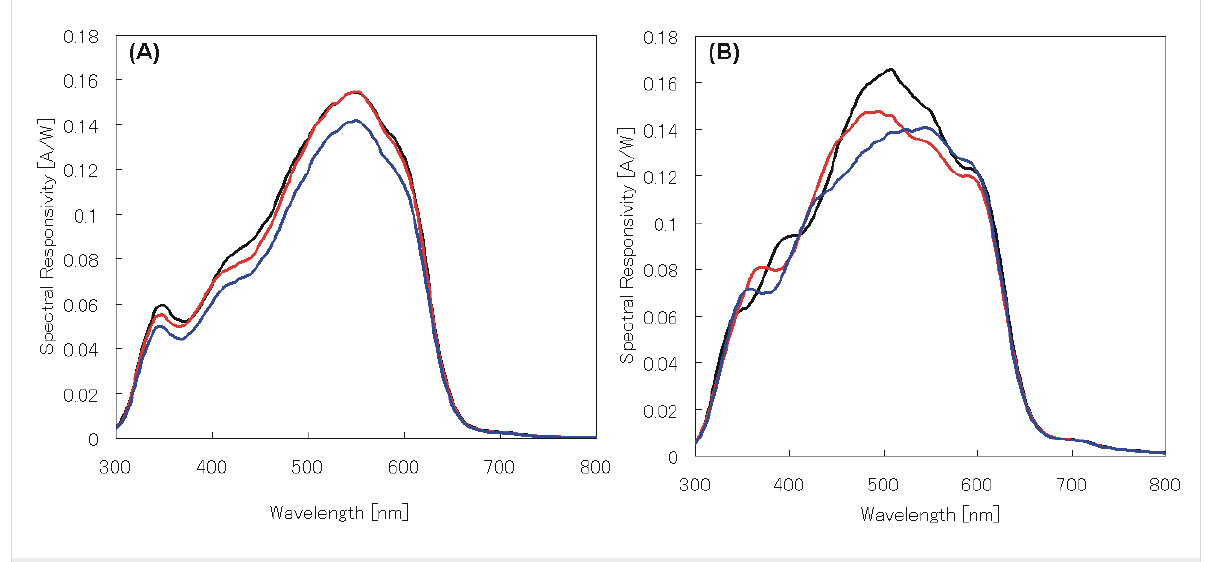
Figure 4: (A) Spectral responsivity of the P3HT: 1a -blended film on the ITO glass annealed at 100–140 °C (100 °C: black, 130 °C: red, 140 °C: blue). (B) Spectral responsivity of the P3HT:PCBM-blended film on the ITO glass annealed at 100–140 °C (100 °C: black, 130 °C: red, 140 °C: blue).